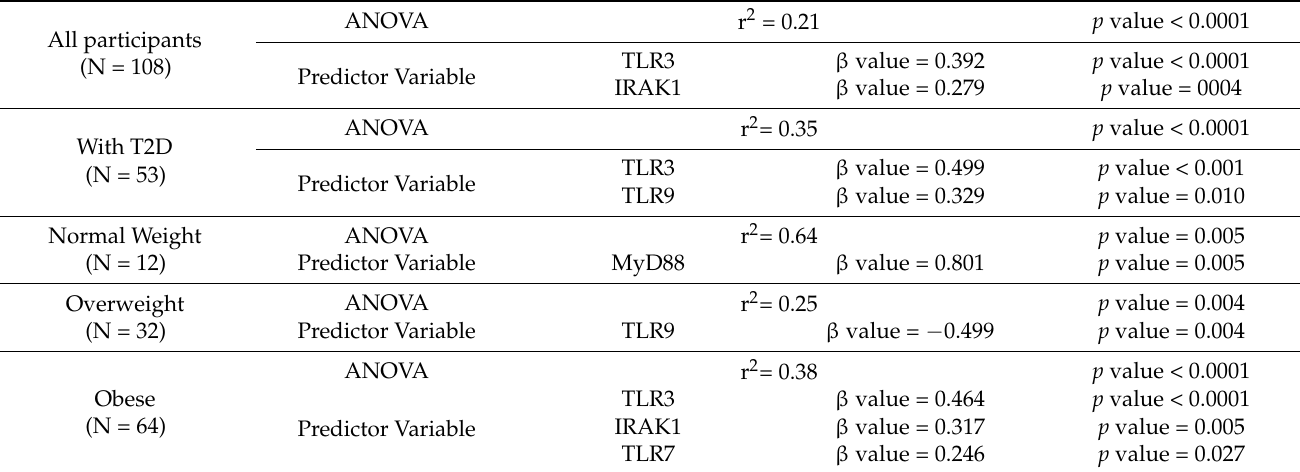
Table 5. The multiple linear regression